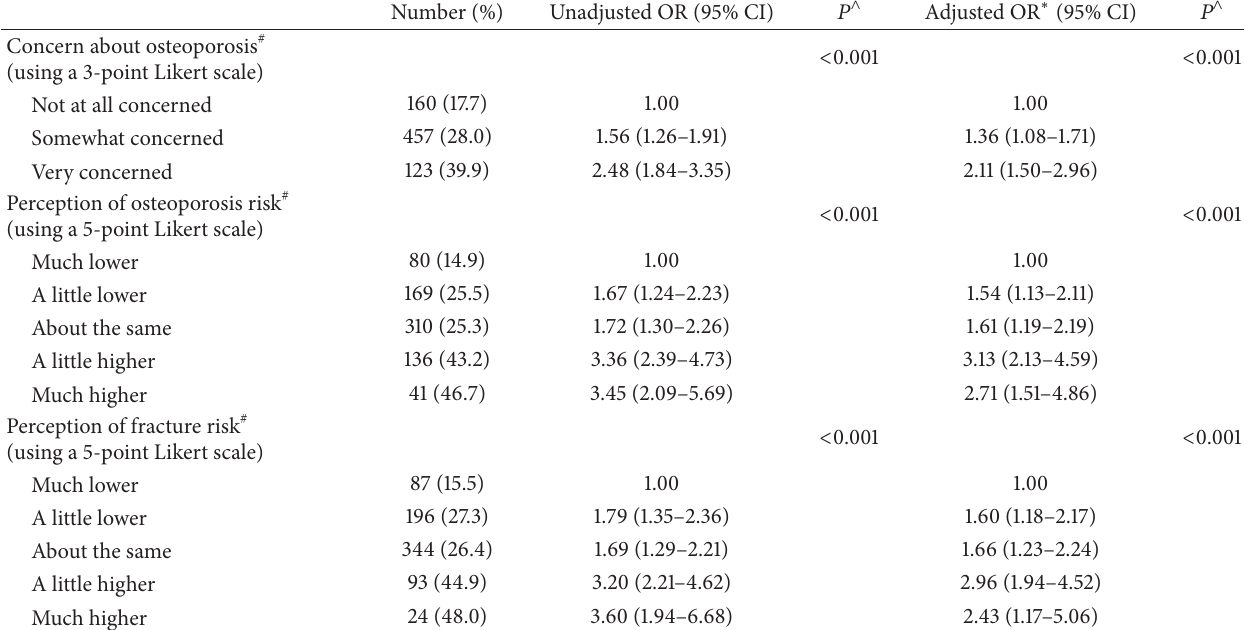
Table 3: Odds ratio (ORs) of seeking medical advice in the next 12 months for covariates about concern and risk perception of